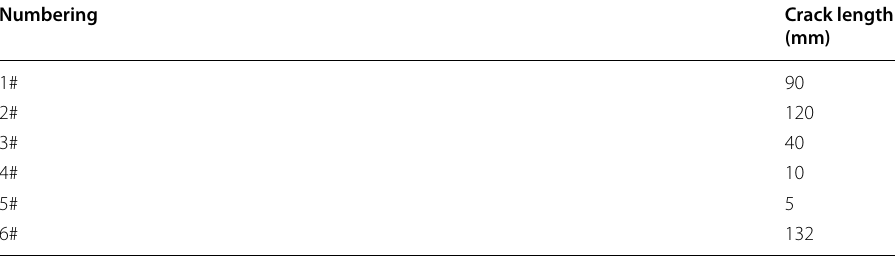
Table 3 Length of weld crack